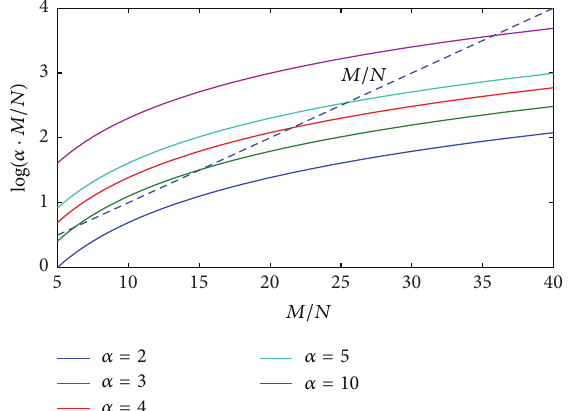
Figure 4: Behavior of (18) for the case 𝑁 = 10 , 𝛼 = 2, 3, 4,5, 10 : ratio 𝑀/𝑁 is required to be between 36 and 40.